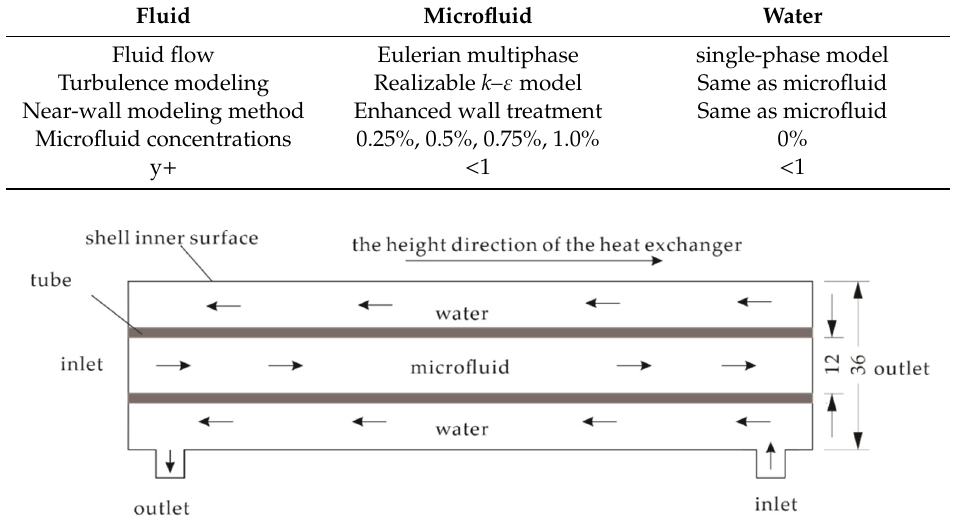
Table 5. Details of the computational conditions.